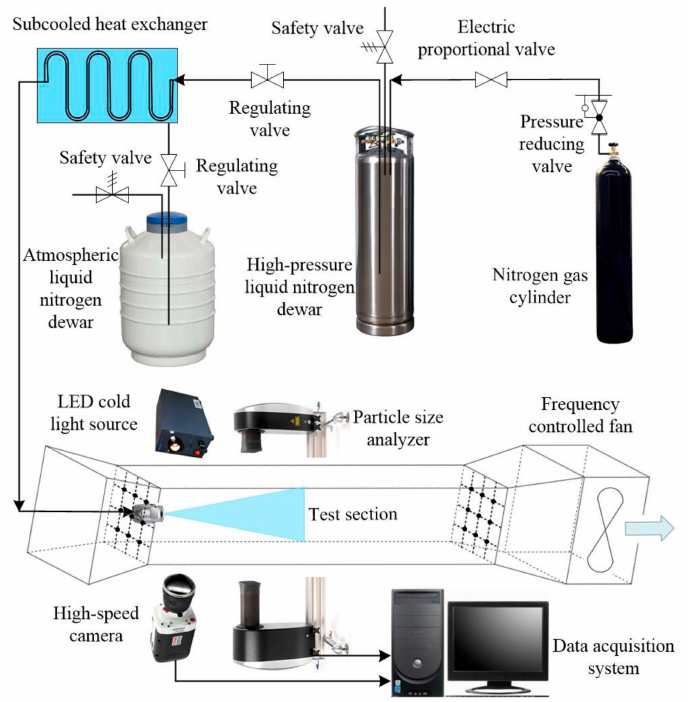
Figure 3. Schematic diagram of the experimental system of LN 2 spray cooling in air